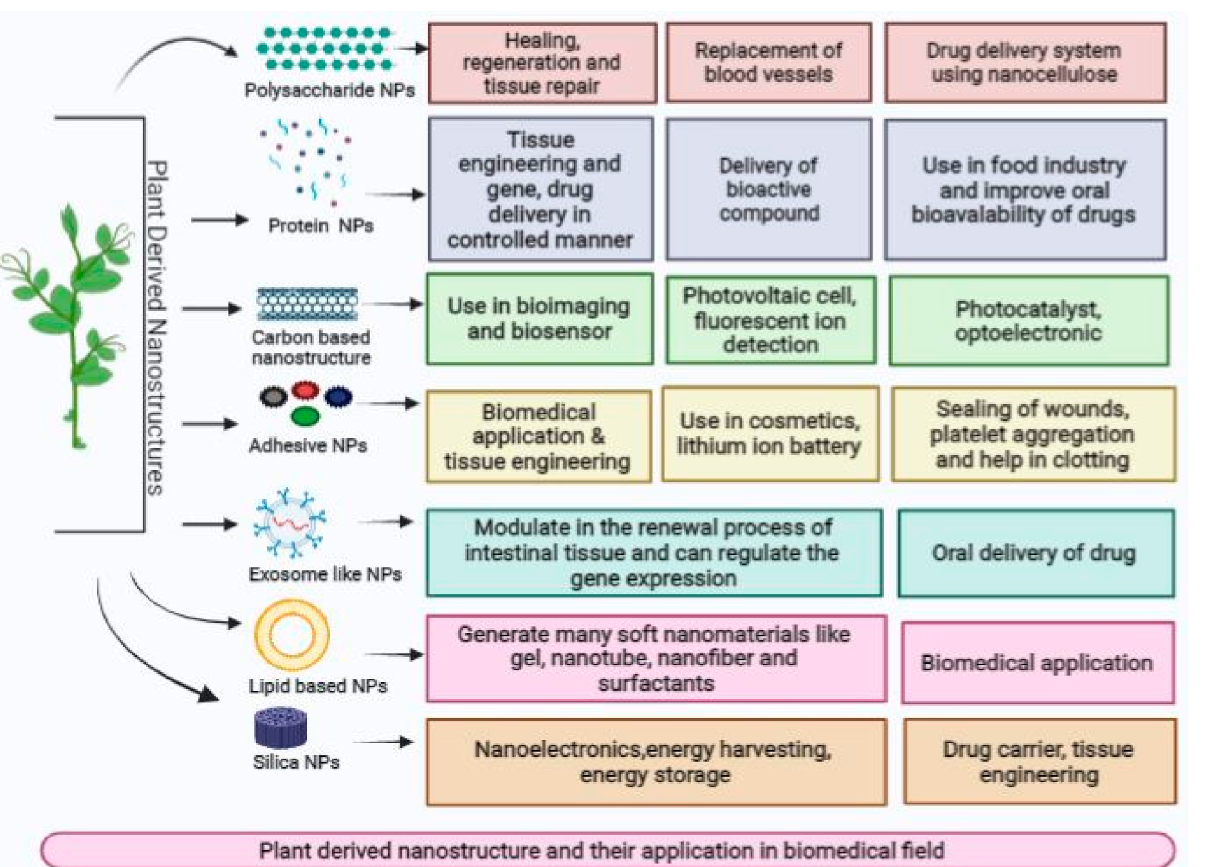
Figure 3. Plant-derived nanostructure and their application in biomedical